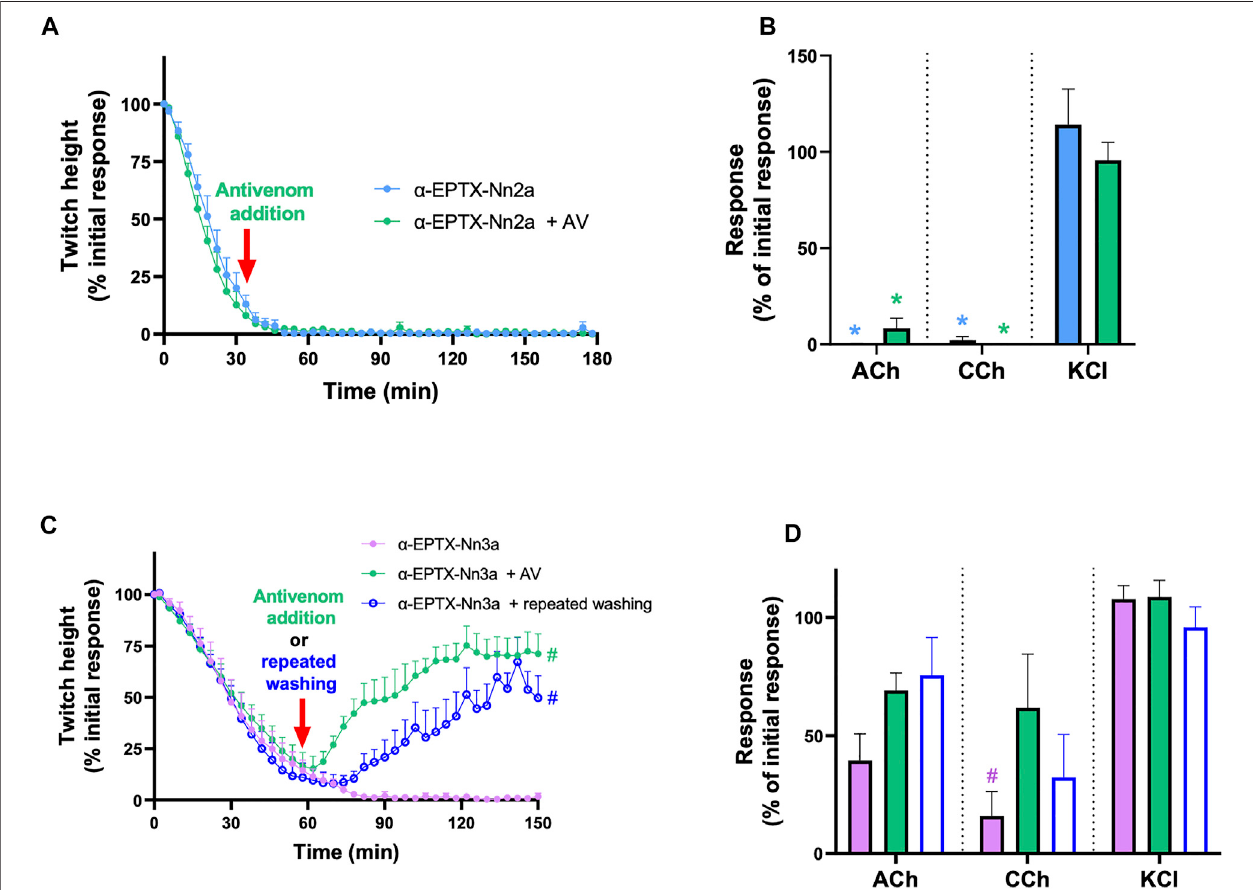
FIGURE7| TheeffectofadditionofIndianPolyvalentantivenom(AV;attherecommendeddose;1 ml/0.6 mg)orrepeatedlywashingthetissuefor10 severy5 min at the t 90 time point on the neurotoxicity of α -Elapitoxin-Nn2a (100 nM) and α -Elapitoxin-Nn3a (100 nM). The addition of antivenom did not affect the inhibition of (A) indirect twitches and (B) responses to exogenous agonists ACh (1 mM) and CCh (20 µM) in the chick biventer cervicis nerve-muscle preparation by α -Elapitoxin-Nn2a. The inhibition of (A) indirect twitches and (B) responsesto exogenousagonists ACh (1 mM) and CCh (20 µM) the chick biventer cervicis nerve-muscle preparation by α -Elapitoxin-Nn3a,werepartiallyreversedbybothadditionofantivenomorrepeatedlywashingthetissue.TheresponsetoKCl(40 mM)isunaffectedby α -Elapitoxin- Nn2aand α -Elapitoxin-Nn3a.* p < 0.05,signi fi cantlydifferentfrom (A) α -Elapitoxin-Nn2aaloneat 180 min(unpaired t -test; n =5)or (B) response tosame agonist before α -Elapitoxin-Nn2a addition (paired t -test, n = 5). # p < 0.05, signi fi cantly different from (C) α -Elapitoxin-Nn3a alone at 150 min (unpaired t -test; n = 5) or (d) response to same agonist before α -Elapitoxin-Nn3a addition (paired t -test, n = 5).